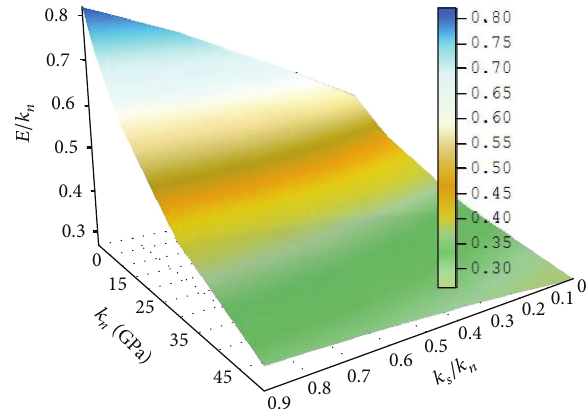
Figure 10: The changes in the internal friction angle at different coefficients of